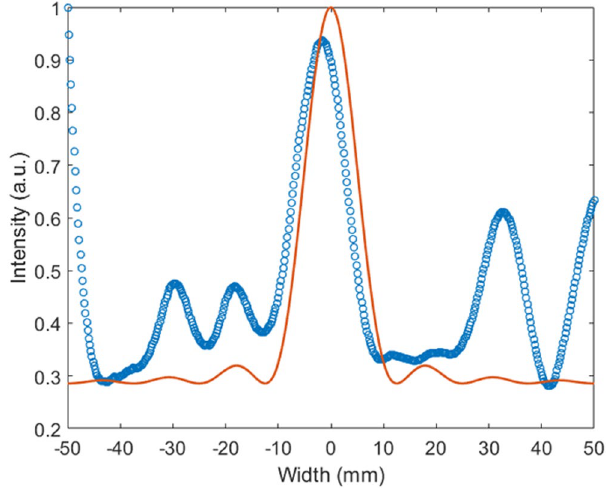
Figure 6. The normalized intensity distribution across the focal spot in the material contrast lens, experimental data shown in circles and solid line shows data fit according to Equation 3.